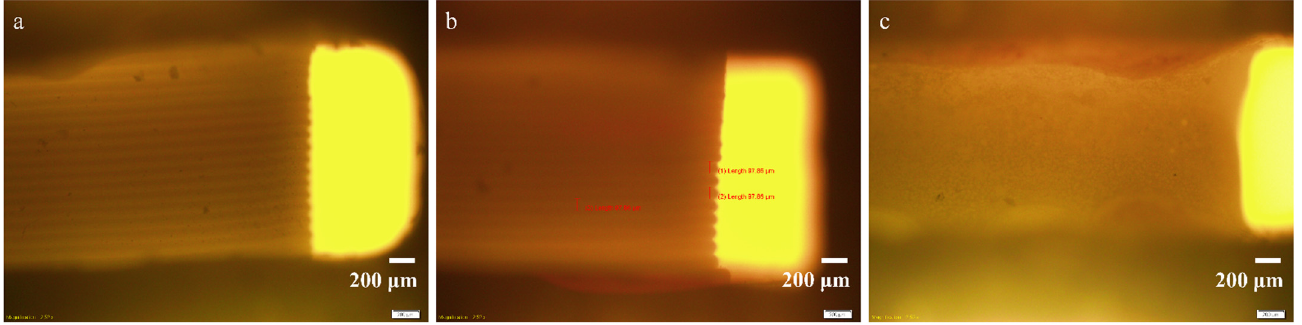
Figure 5. Optical images recorded in bright field, in reflectivity at a magnification of 2.52 × for the original channel ( a ); PE side ( b ) and PPE side of the channel ( c ).